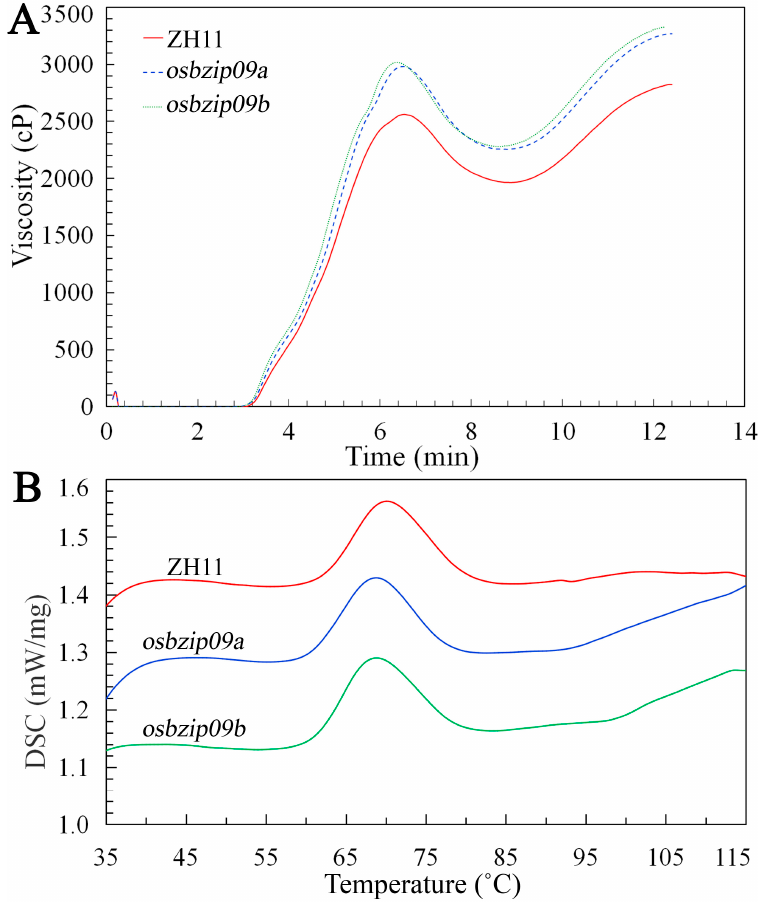
Figure 4. Pasting and thermal properties of endosperm starch from different rice lines. ( A ) shows the starch RVA curve; ( B ) shows the endothermic curves of the starches as determined by DSC.